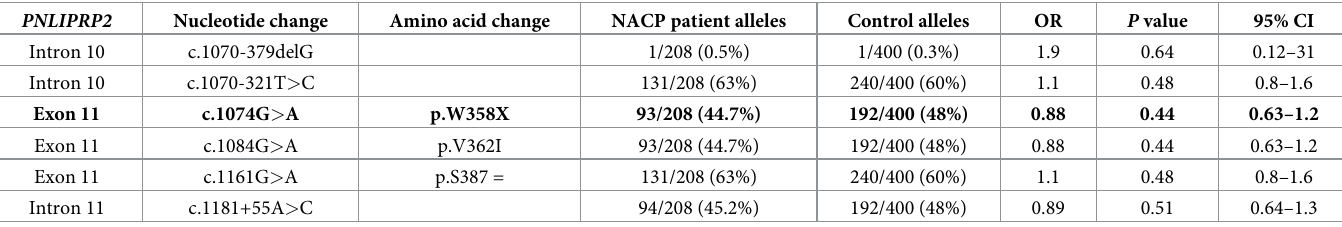
Table 5. Allele frequency of PNLIPRP2 variants in patients with non-alcoholic chronic pancreatitis (NACP) and controls without pancreatic disease. PNLIPRP2